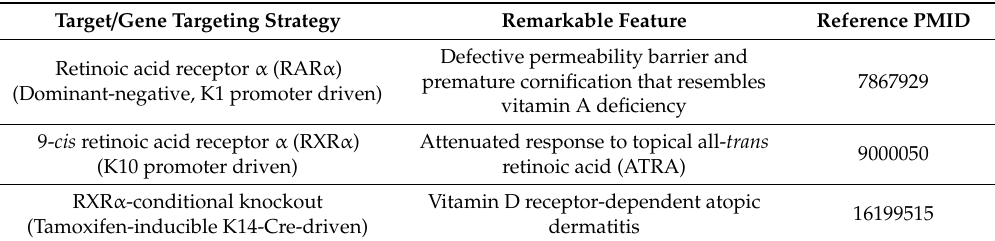
Table 4. Vitamin A (retinoic acid) signaling